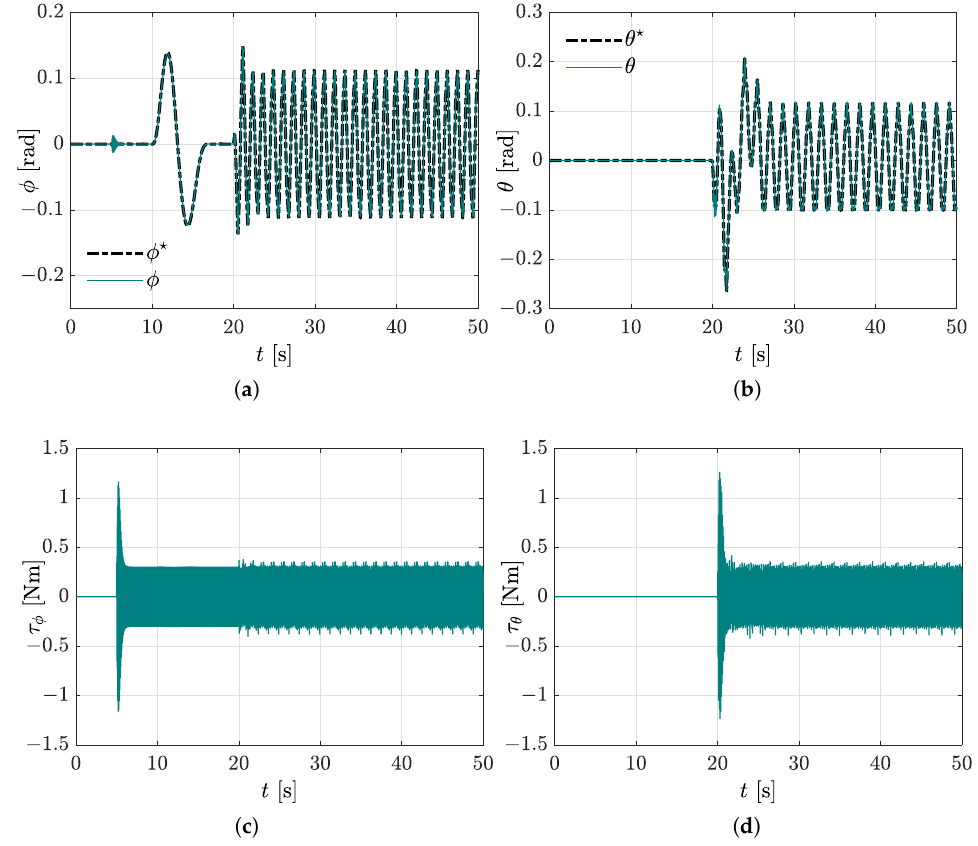
Figure 7. Roll and pitch controlled motion. ( a ) Desired φ (cid:63) angle tracking. ( b ) Desired θ (cid:63) angle tracking. ( c ) Computed control input τ φ . ( d ) Computed control input τ θ